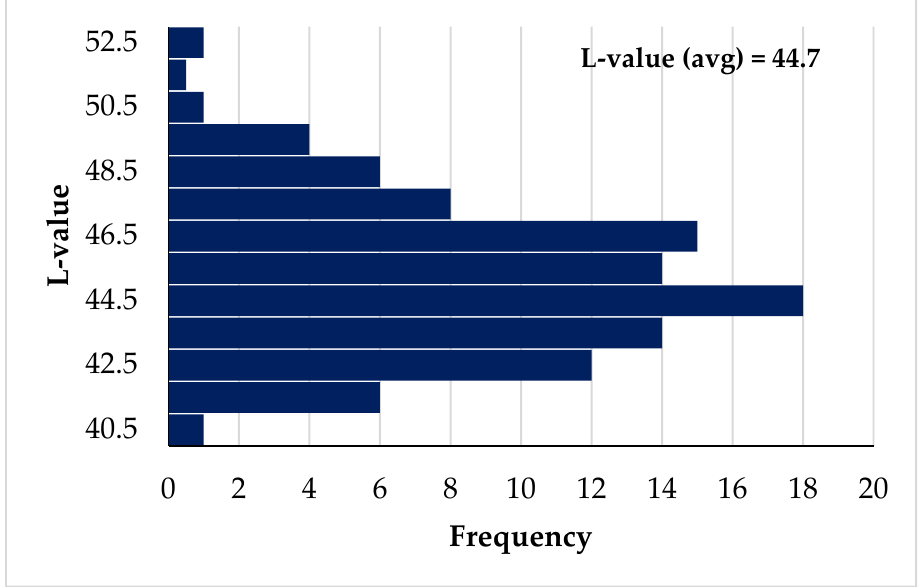
Figure 4. Redrawn histogram of L-value (lightness) distribution of breast meat fillets in young turkeys ( n = 3000). Data from McCurdy et al. [21].